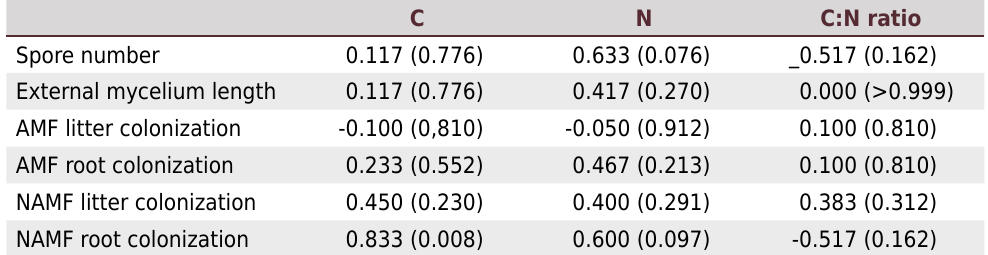
Table 6. Correlations among carbon, nitrogen, carbon to nitrogen ratio, and fungal variables. Spearman coefficient